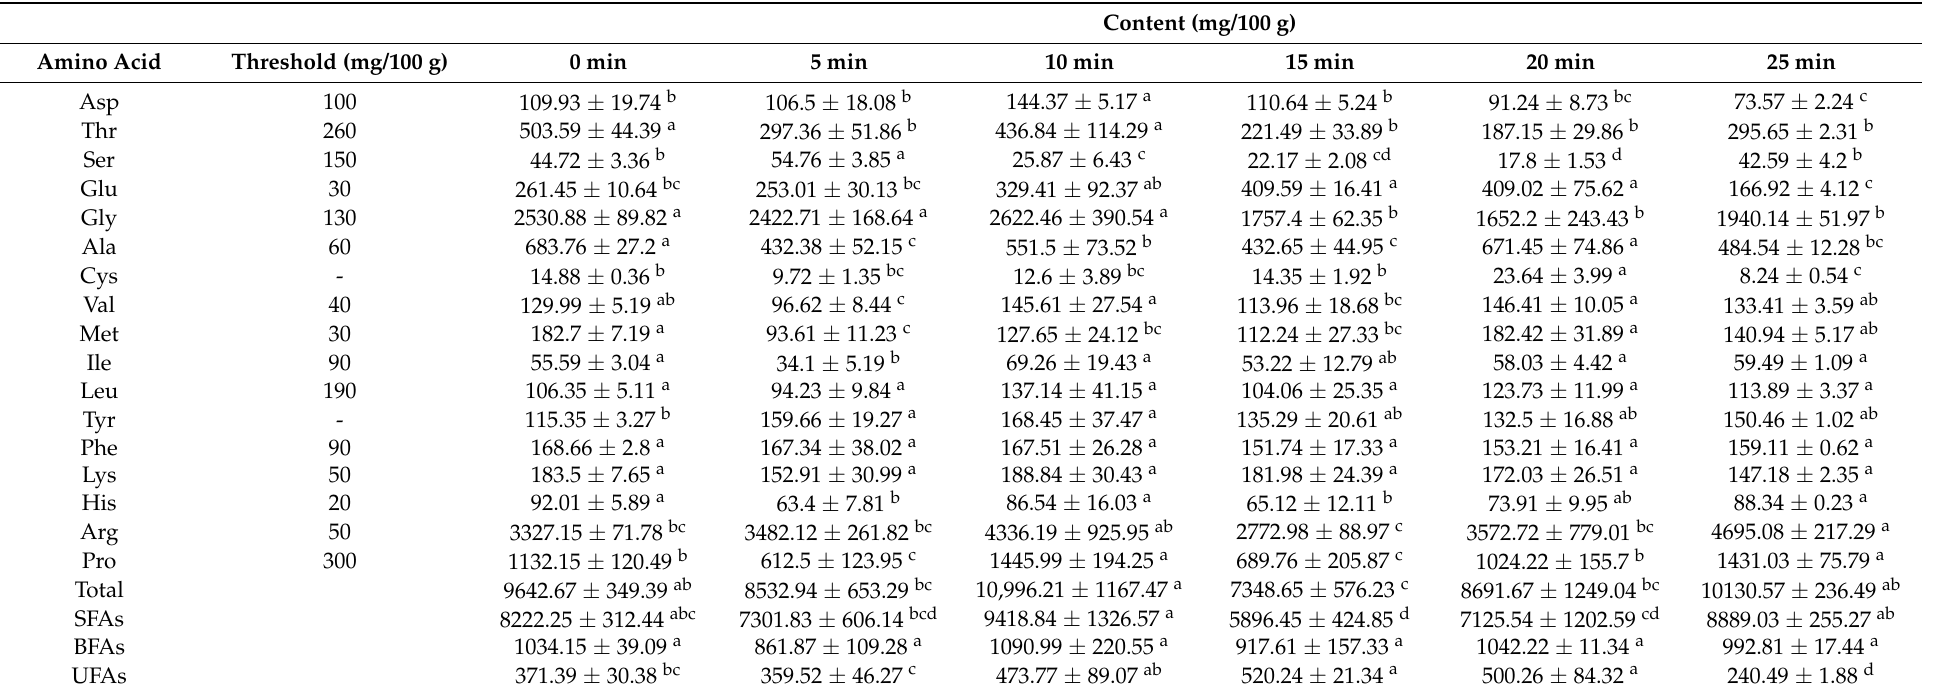
Table 3. The contents of free amino acids on a dry basis of swimming crab during steaming (mg/100 g).